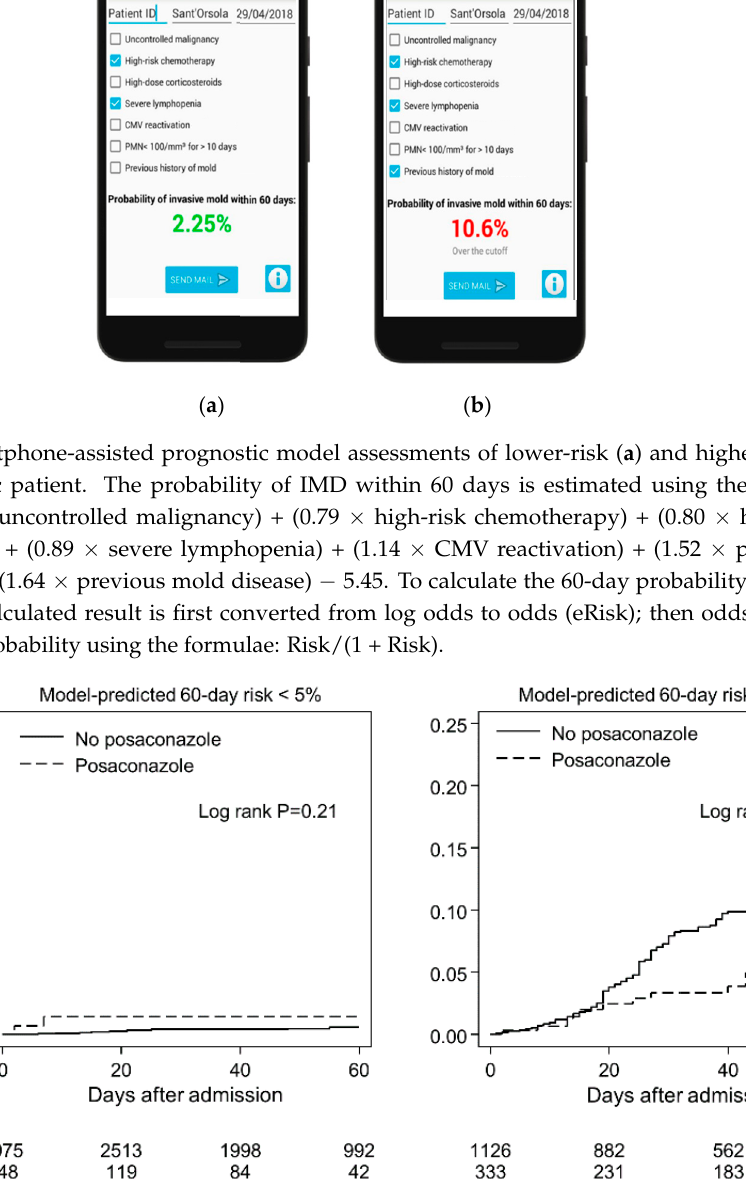
Figure 5. Smartphone ‐ assisted prognostic model assessments of lower ‐ risk ( A ) and higher ‐ risk ( B ) nonneutropenic patient. The probability of IMD within 60 days is estimated using the formula: Risk = (0.68 × uncontrolled malignancy) + (0.79 × high ‐ risk chemotherapy) + (0.80 × high ‐ dose corticosteroids) + (0.89 × severe lymphopenia) + (1.14 × CMV reactivation) + (1.52 × prolonged neutropenia) + (1.64 × previous mold disease) − 5.45. To calculate to % 60 ‐ day probability from the formula, the calculated result is first converted from log odds to odds (eRisk); then odds must be converted to probability using the formulae: Risk/(1 + Risk).